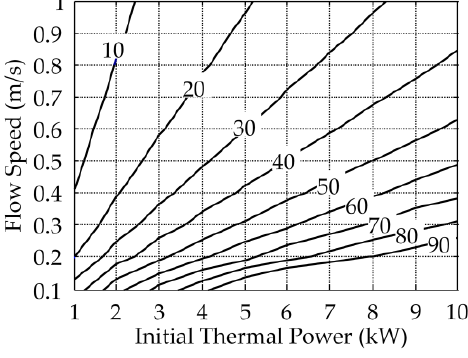
Figure 18. Temperature incease curves.